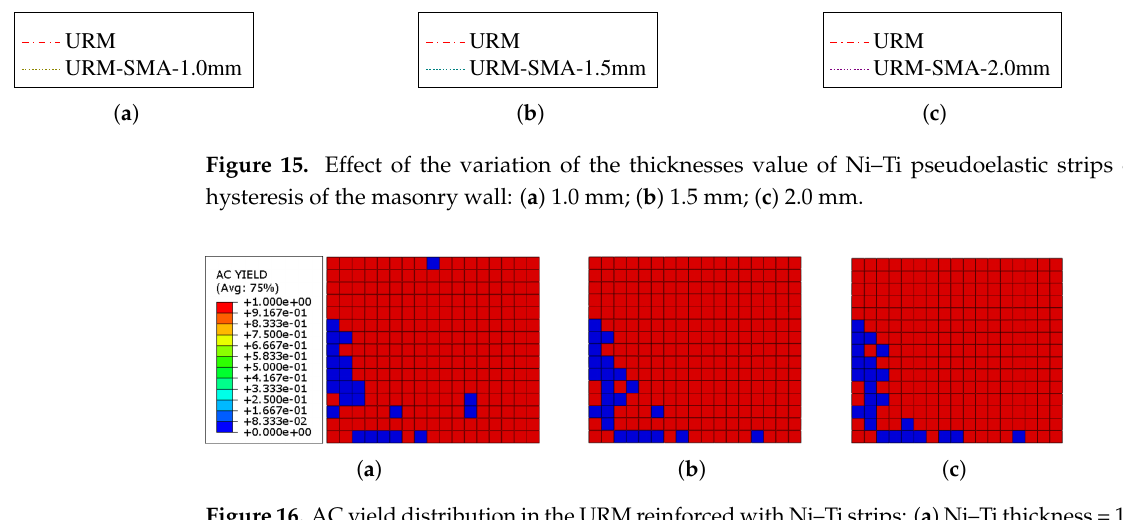
Figure 16. AC yield distribution in the URM reinforced with Ni–Ti strips: ( a ) Ni–Ti thickness = 1.0 mm; ( b ) Ni–Ti thickness = 1.5 mm; ( c ) Ni–Ti thickness = 2.0